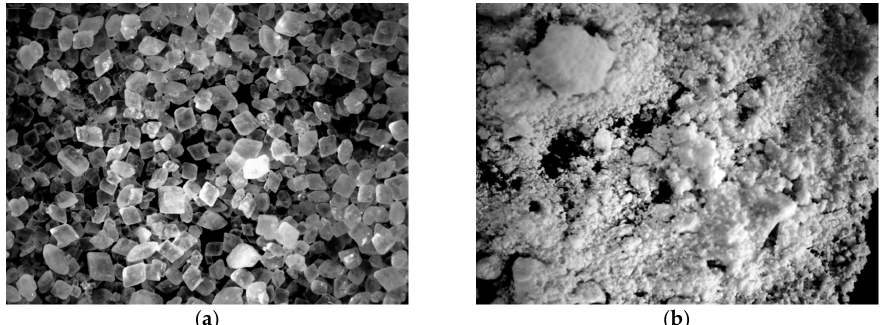
Figure 1. Chemical structure of ( a ) APIB-POSS and ( b ) AEAPIB-POSS.